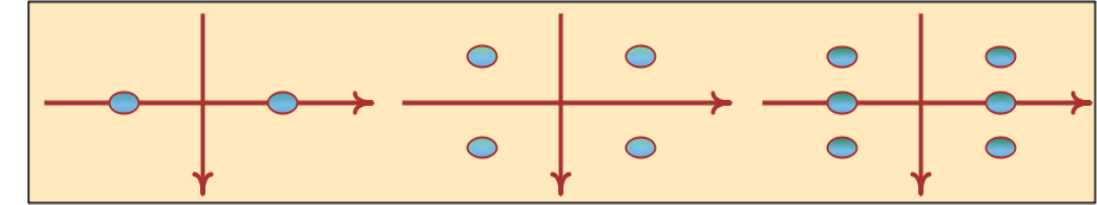
Figure 1. The three scenarios: illustrations of the subsets of zeros, in pairs, quadruplets, and sextuplets.